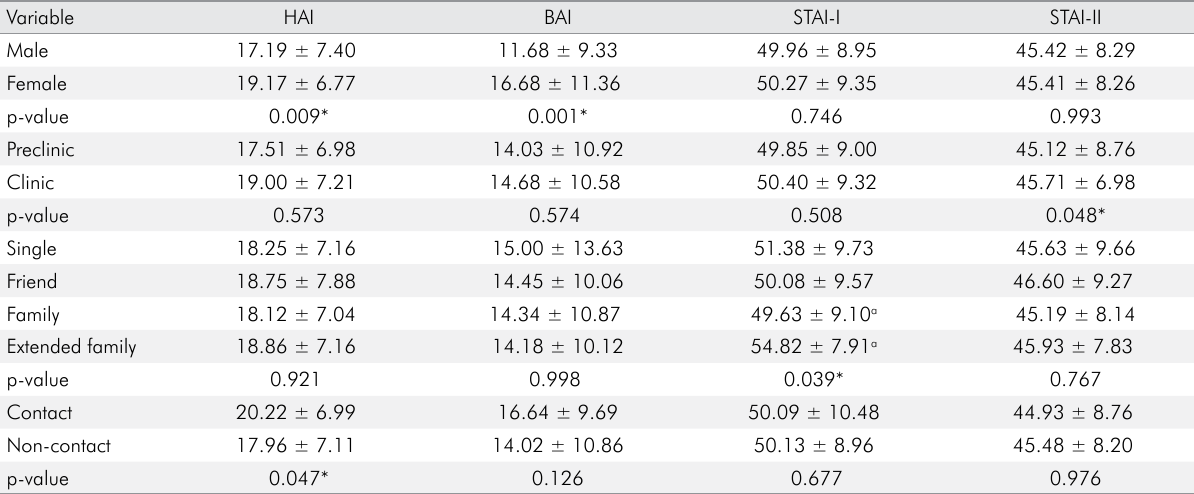
Table 1. Relationship between different parameters and HAI, BAI, STAI-I, STAI-II level of students.